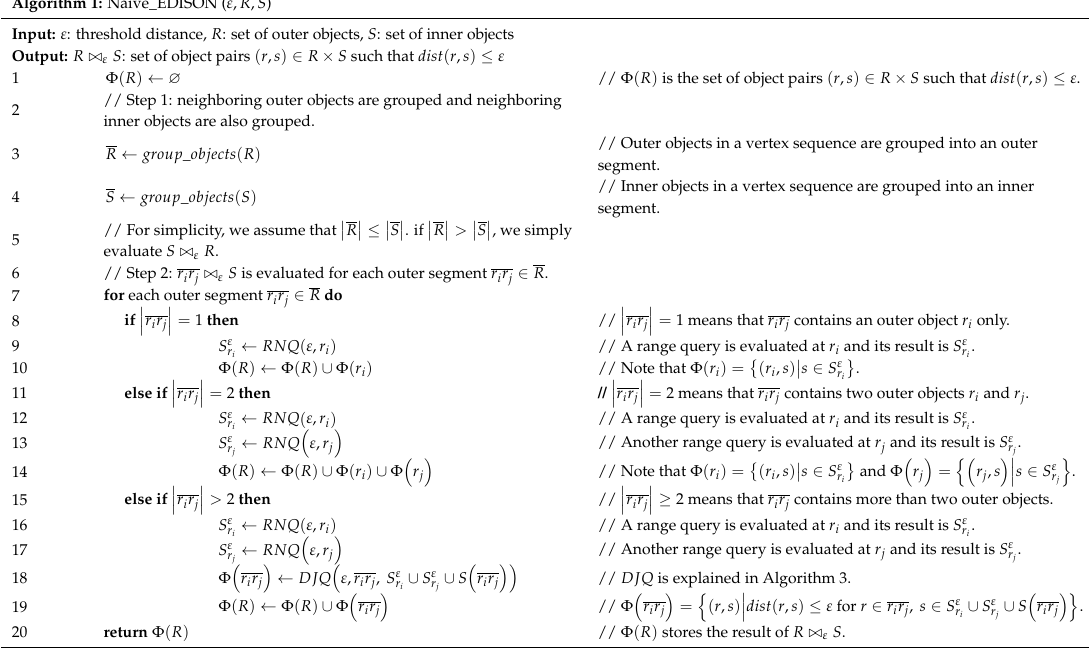
Algorithm 1: Naive_EDISON ( ε , R , S